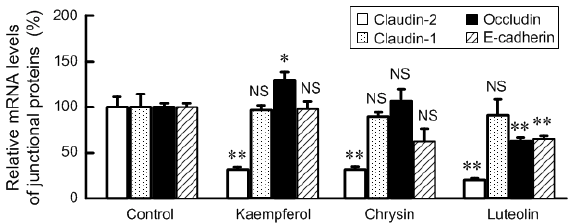
Figure 5. Effects of flavonoids on mRNA levels of junctional protein. The cells were incubated in the absence and presence of 50 μ M flavonoids for 6 h. After isolation of total RNA, quantitative real-time PCR was performed using specific primers for claudin-1, claudin-2, occludin, and E-cadherin. n = 4. ** p < 0.01 and * p < 0.05 significantly different from control. NS, not significantly